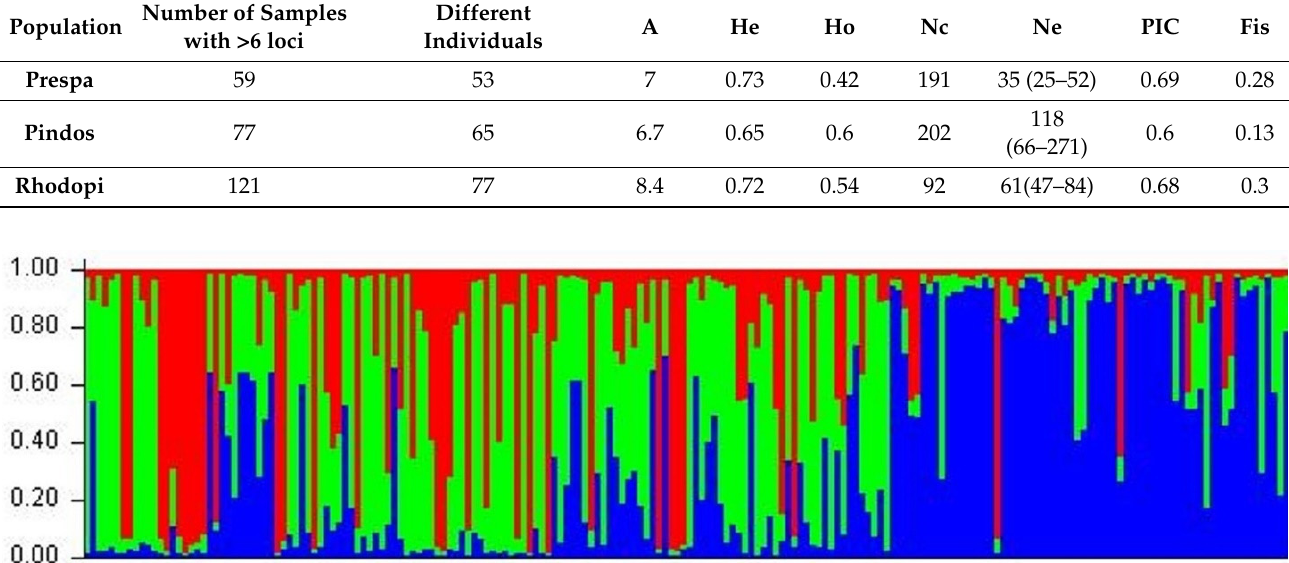
Table 8. Average estimates of number of alleles (A), expected heterozygosity (He), observed heterozy- gosity (Ho), census population size (N C ), effective population size (Ne), polymorphic information content (PIC), and inbreeding coefficient (Fis) in the three project areas.